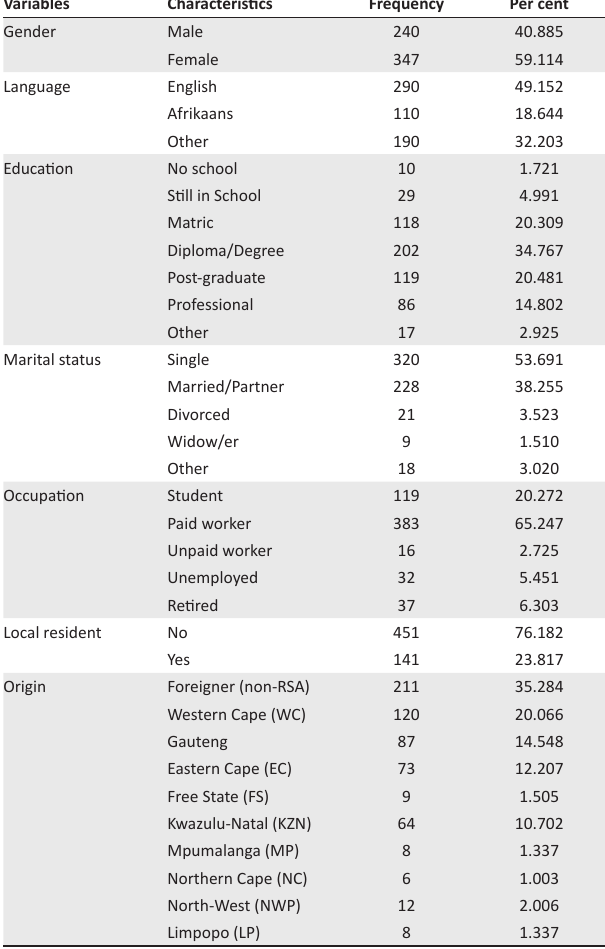
TABLE 2-A1: Frequency description of the sample.